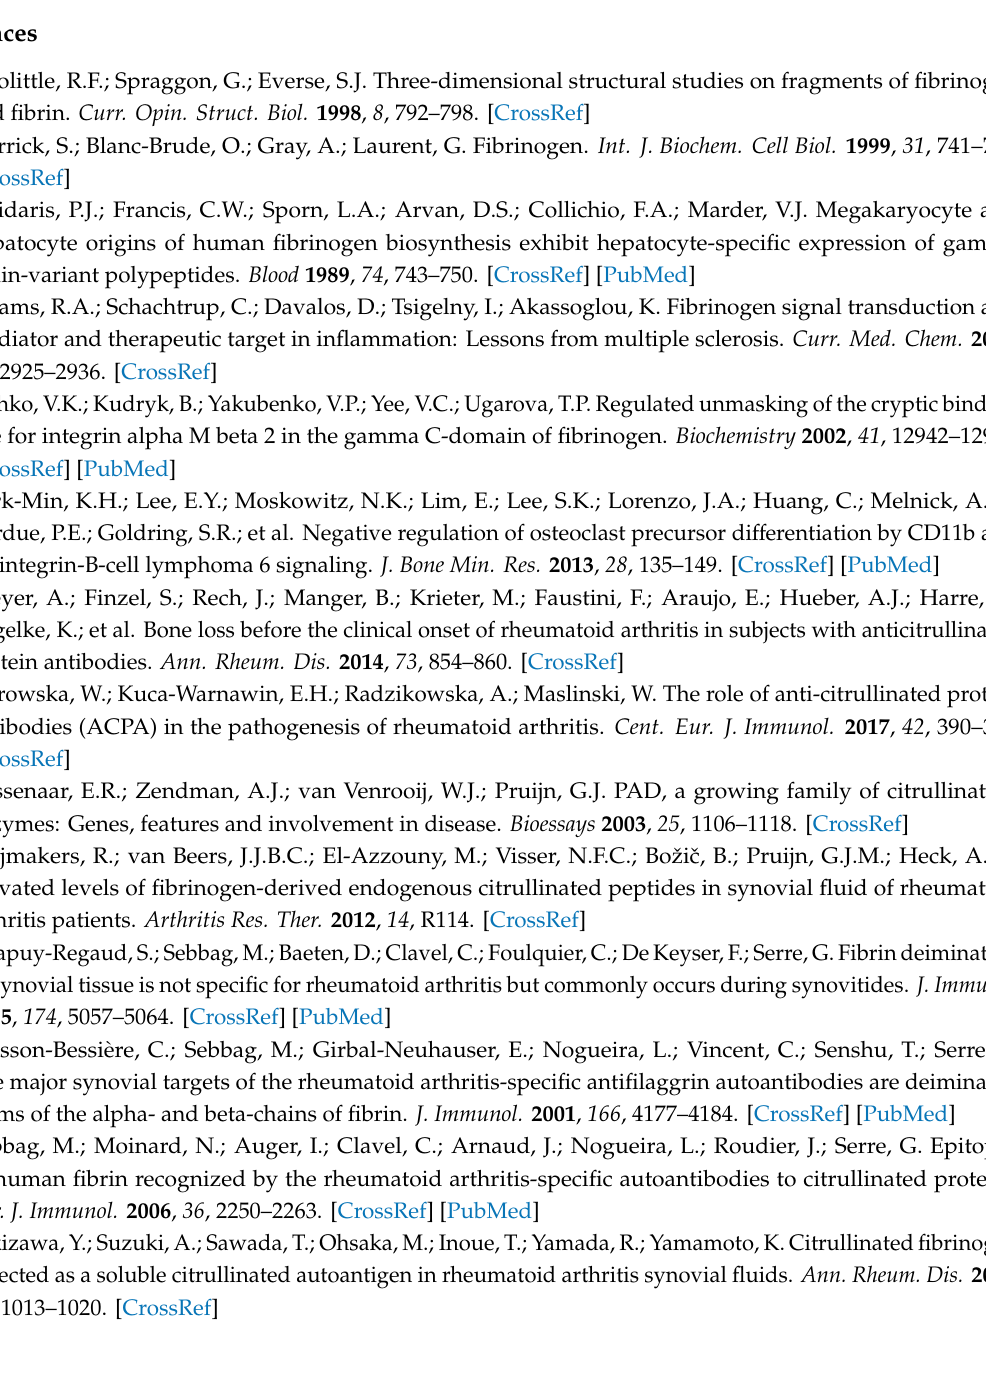
Figure S1: Sequence comparison between bovine and human fibrinogen according to α , β , and γ